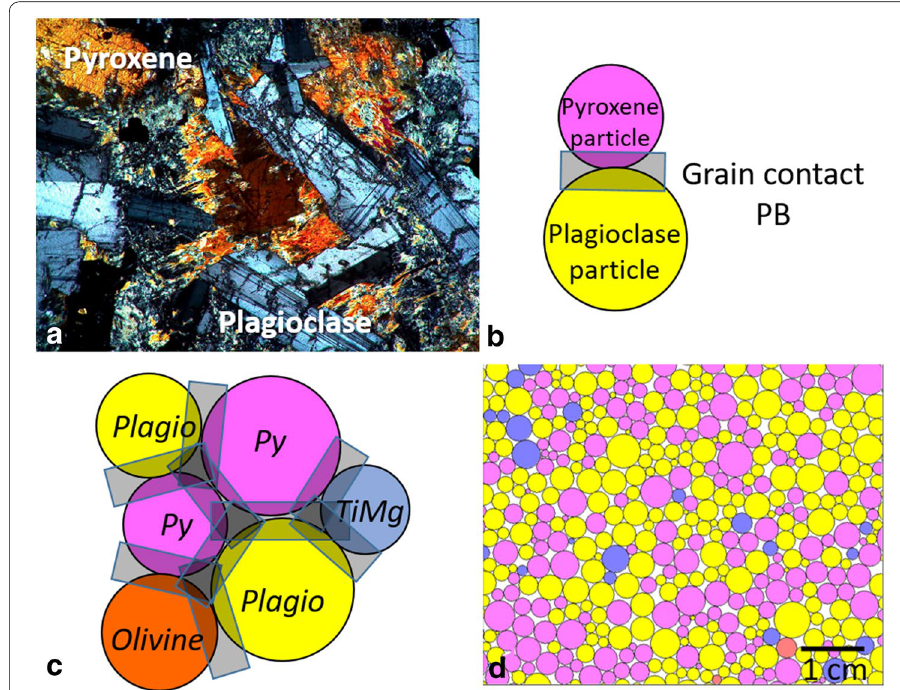
Fig. 7 Elaboration of the numerical rock model: conceptualization and geometric setup. a Thin section of the dolerite from RN‑15/IDDP‑2 (courtesy of HS Orka). b Conceptualisation: each crystal grain is modeled by a numerical particle; contacts between grains are modeled by parallel bonds (PB). c Schematic view of a detail of the numerical rock model: bonded particles aggregate ( Py pyroxene, Plagio plagioclases, TiMg titanomagnetite). d View of the particles of the numerical dolerite